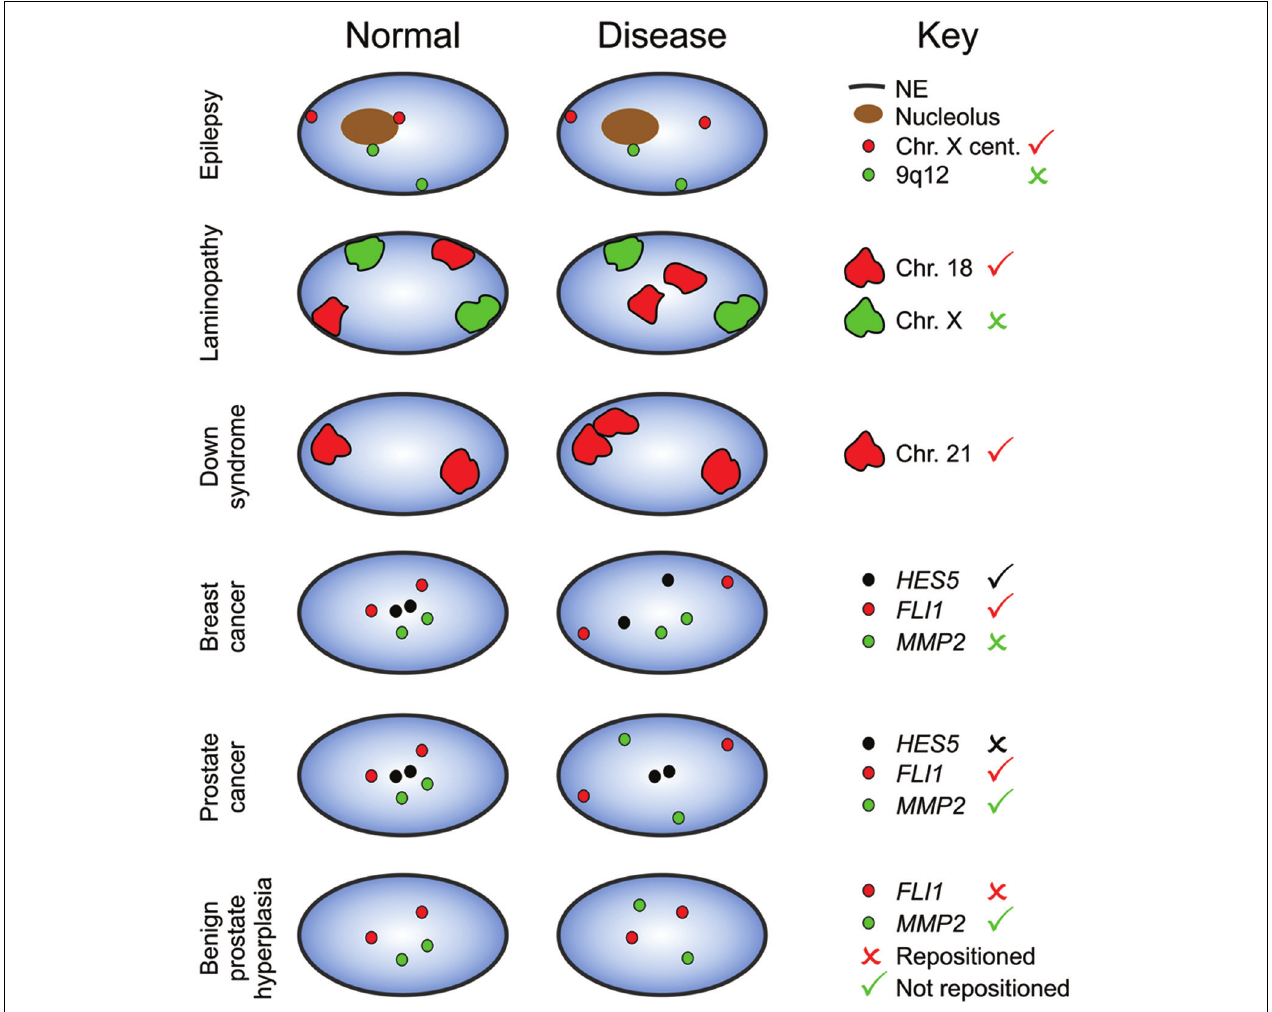
FIGURE 2 | Loci-specific reorganization of the genome in disease. Certain loci adopt alternative nuclear positions in disease (tick) compared to normal cells, whilst the positions of other loci are conserved in disease (cross). Moreover, the repositioning of some loci is disease specific, and although a gene repositions in one disease, it may not in another disease. Blue, nucleus; NE, nuclear envelope; Cent.,